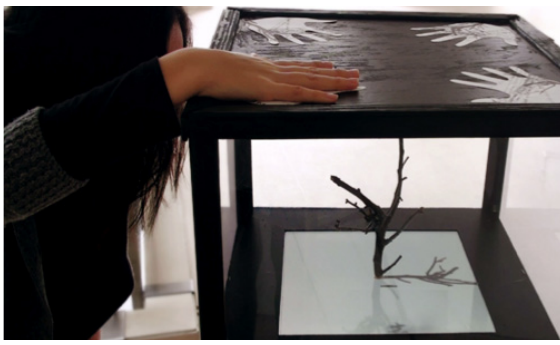
FIGURE 2 | Participants take a look at the digital con- tents while putting their hands on the top of the display to control the